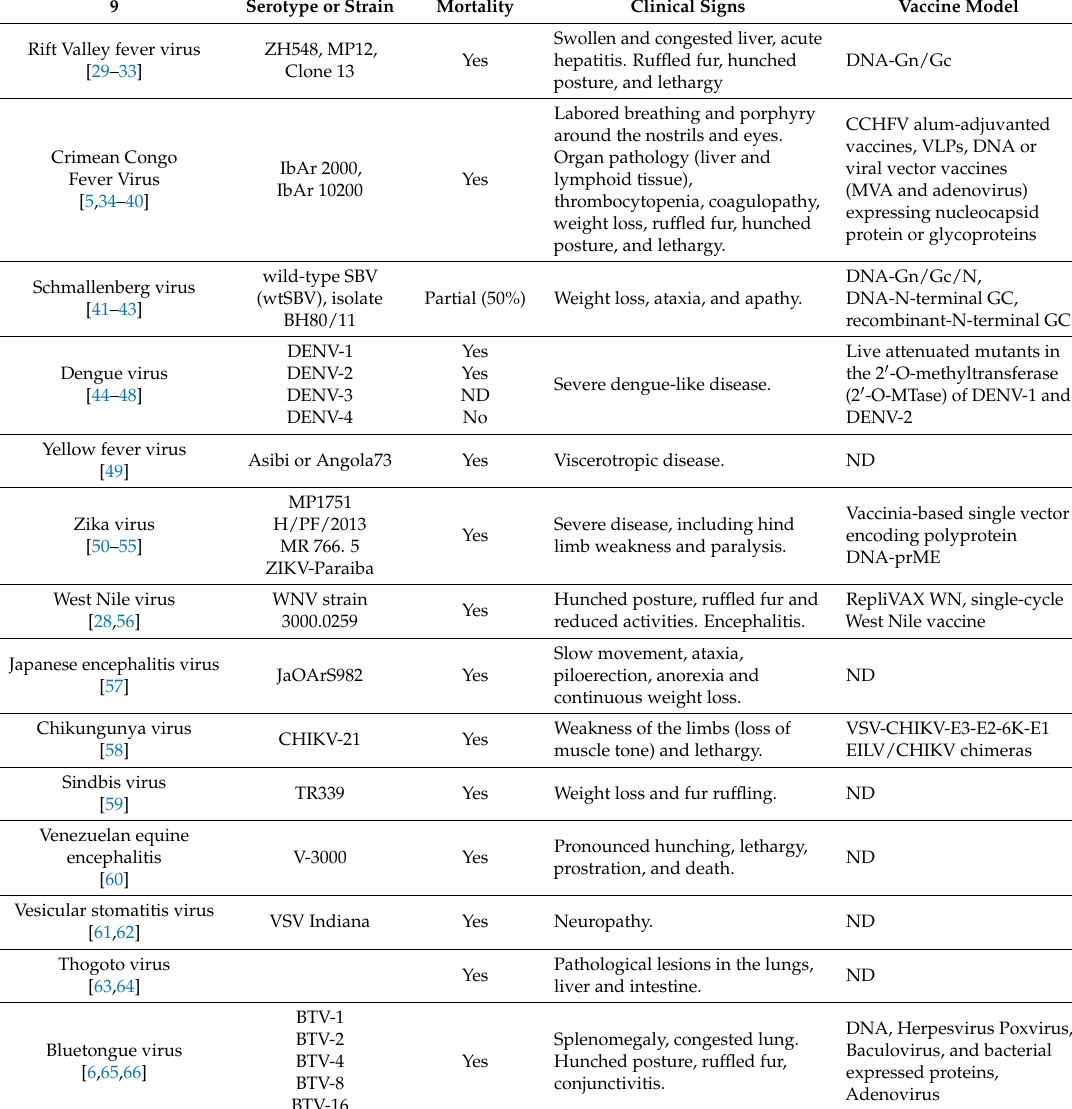
Table 1. Summary of viruses that have used the IFNAR( − / − ) mouse model to study pathology and vaccine efficacy. Serotype or